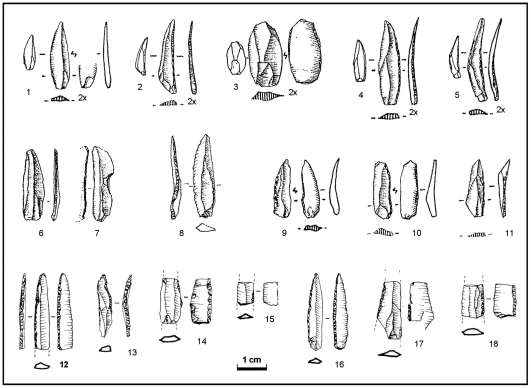
“Dufour bladelets”: in the Portuguese Upper Paleolithic [54]. 1–5, 9–11.Early Magdalenian of Cerrado Novo; 6–8. Gravettian of Vale Comprido – Barraca and Terra do Manuel; 12–15. Pego do Diabo layer 2 (intact Pleistocene deposits); 16–18. Pego do Diabo layer 2D (Pleistocene deposits with Holocene intrusions). These items all fit the rather vague consensus definition of the Dufour bladelet type, although no. 13 is classified separately in Table 2 because it features bilateral direct retouch. The non-Aurignacian Dufours differ from the Pego do Diabo material in size, mode of retouch and blank technology (see Table 8). Note, in particular, the hypermicrolithic nature of the Early Magdalenian specimens, and the obtuse (or naturally pointed) distal extremities and marginal retouch of the Gravettian ones. In contrast, the material from Pego do Diabo is elongated, more robust, bilaterally pointed, and features ventral sides modified via semi-abrupt, often invasive retouch of a kind never used in the Gravettian or the Magdalenian.